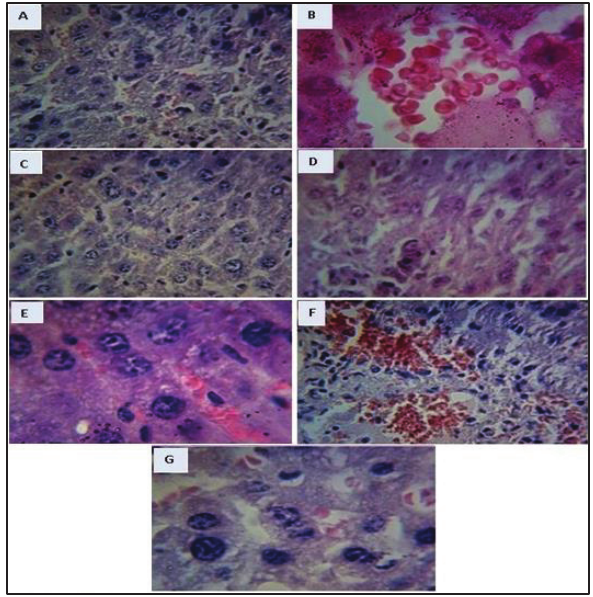
Fig-4: Histopathological examination of liver samples collected from BALB/c